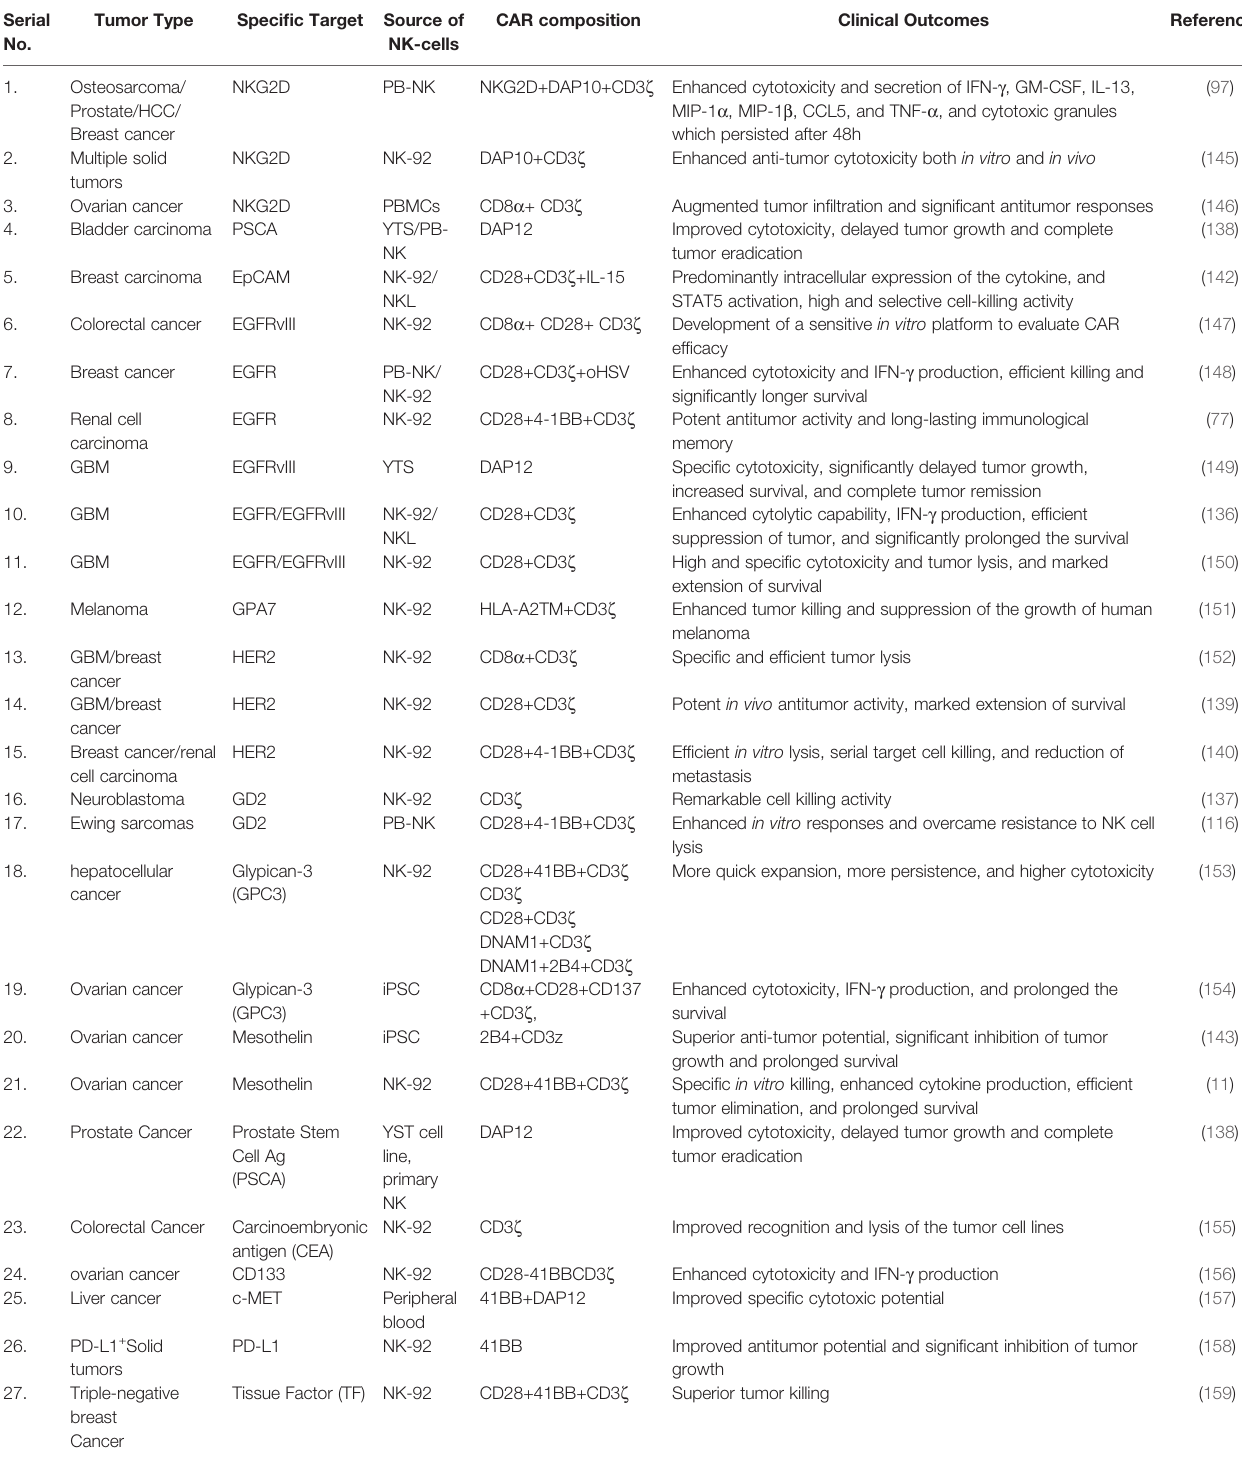
TABLE 3 | Recent preclinical studies employing CAR-NK cells against various solid tumors. Serial